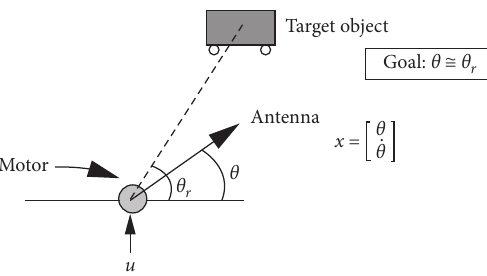
Figure 6: Angular positioning system.